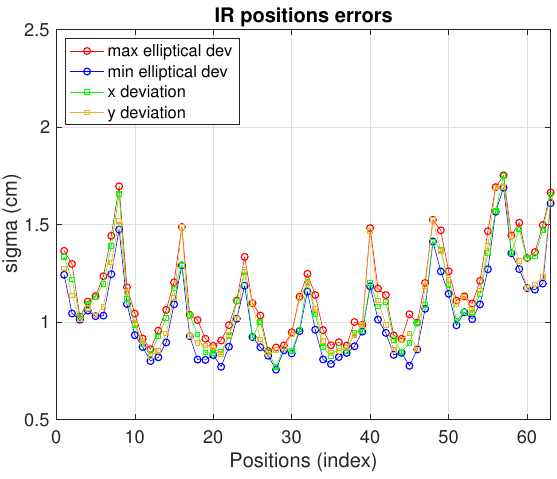
Figure 8. Infrared sensor positioning errors. Table 3. Infrared. Estimation-clouds shape and measurements